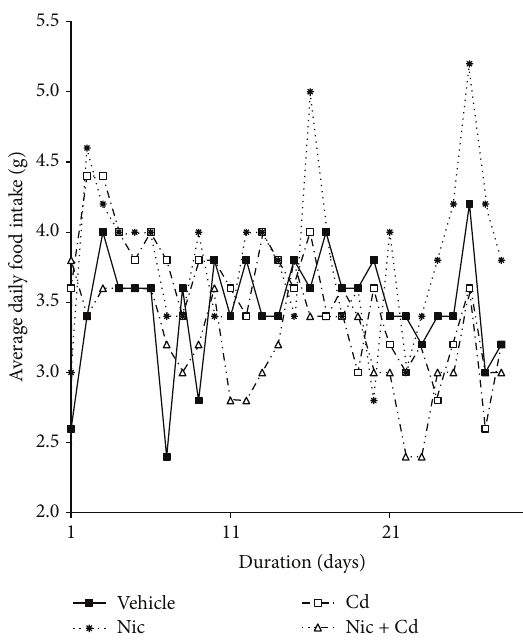
Figure 2: Average daily food intake (P28 to P56) in female adolescent mice. Similar to the observations in weight changes, the average daily food intake increased in the nicotine and cadmium treated groups when compared with the control. Consequent of nicotine-cadmium treatment, a decline in food intake was observed around P46 versus the saline treated mice. This precedes the weight loss in this group (P50) as shown in Figure 1. Each point represents daily recorded food intake/group expressed as mean ± SEM.